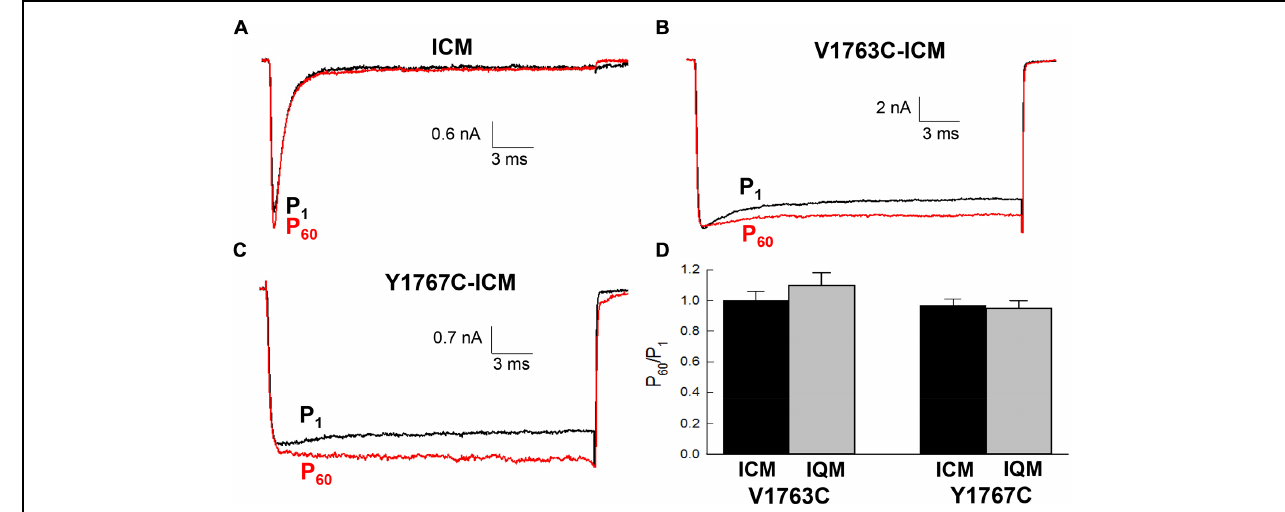
V1767C-ICM mutant measured with 1 mM MTSET in the patch pipette. (C) Current of the Y1767C-ICM mutant measured in the presence of MTSET. (D) Currents were measured immediately after break in (P 1 ) and after 5 min (P 60 ). The P 60 /P 1 ratios of the V1763C-ICM and Y1767C-ICM mutants were not different after 5 min of internal MTSET. Also shown are the P 60 /P 1 ratios of the